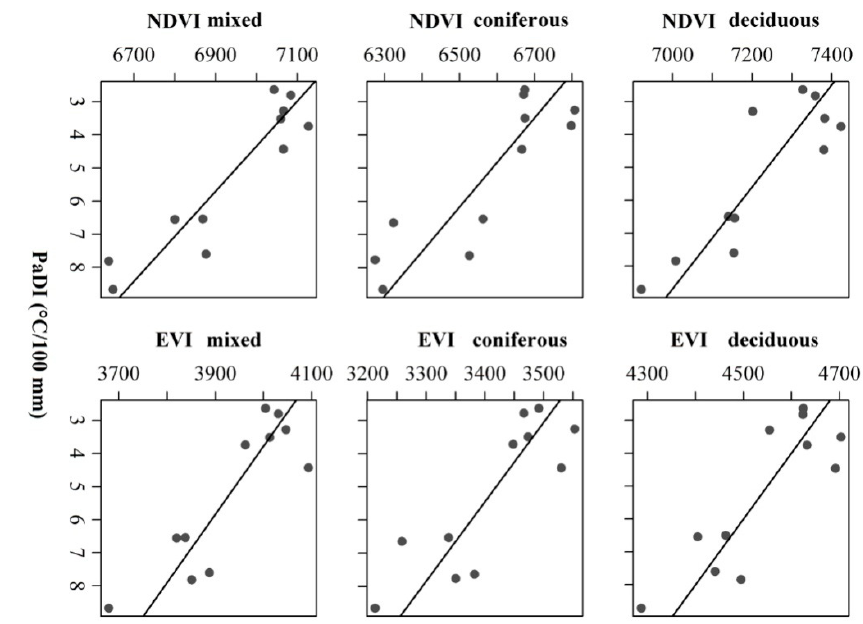
Figure 9. Determination coe ffi cients between the spectral indices of MODIS images and PaDI for the time period 2000–2010.